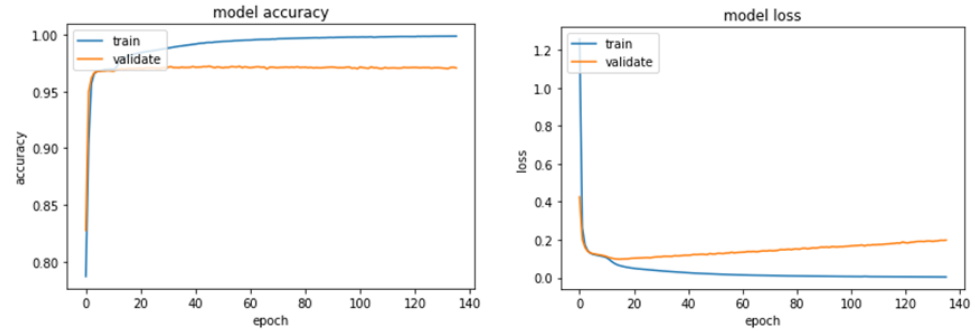
Figure 9. Training and validation loss curves on Bi-LSTM model.